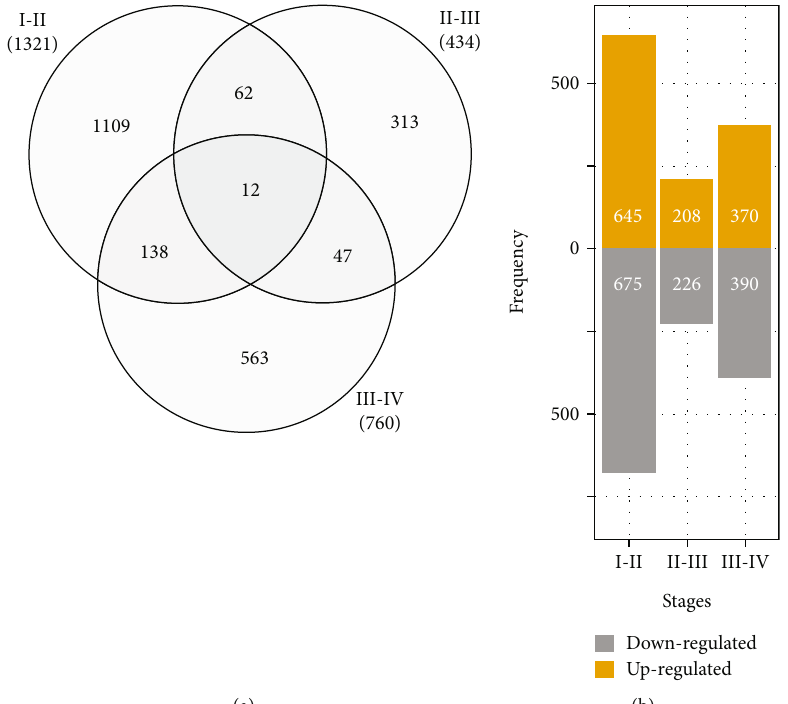
Figure 2: Overview of DEGs. (a ) Distribution of DEGs between consecutive somatic embryo developmental stages. ( b ) Number of up- or downregulated DEGs between